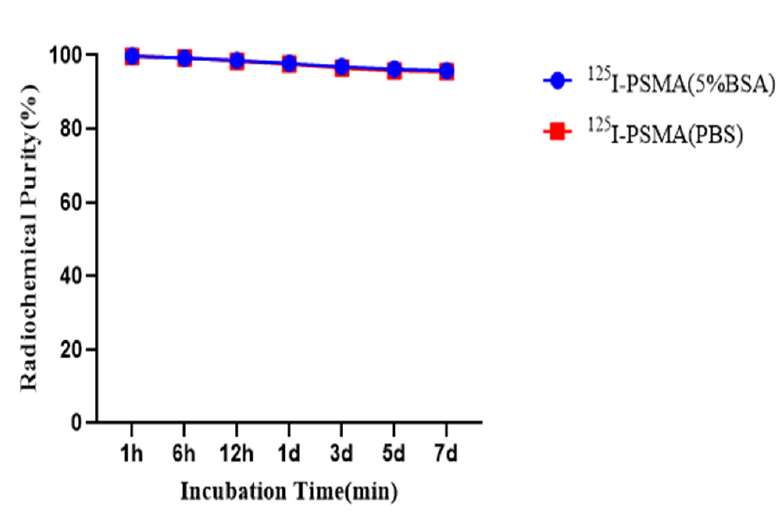
Figure 5. The Ki value of PSMA.